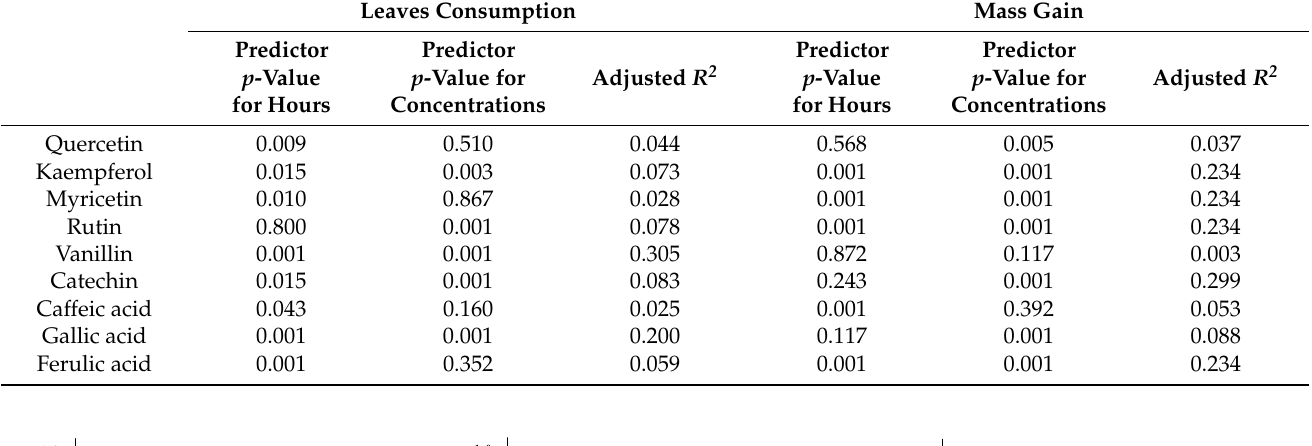
Table 5. Regression analysis for leaves consumption and mass gain of Chilesia rudis in dose-response experiments. Italics number mean significant differences.